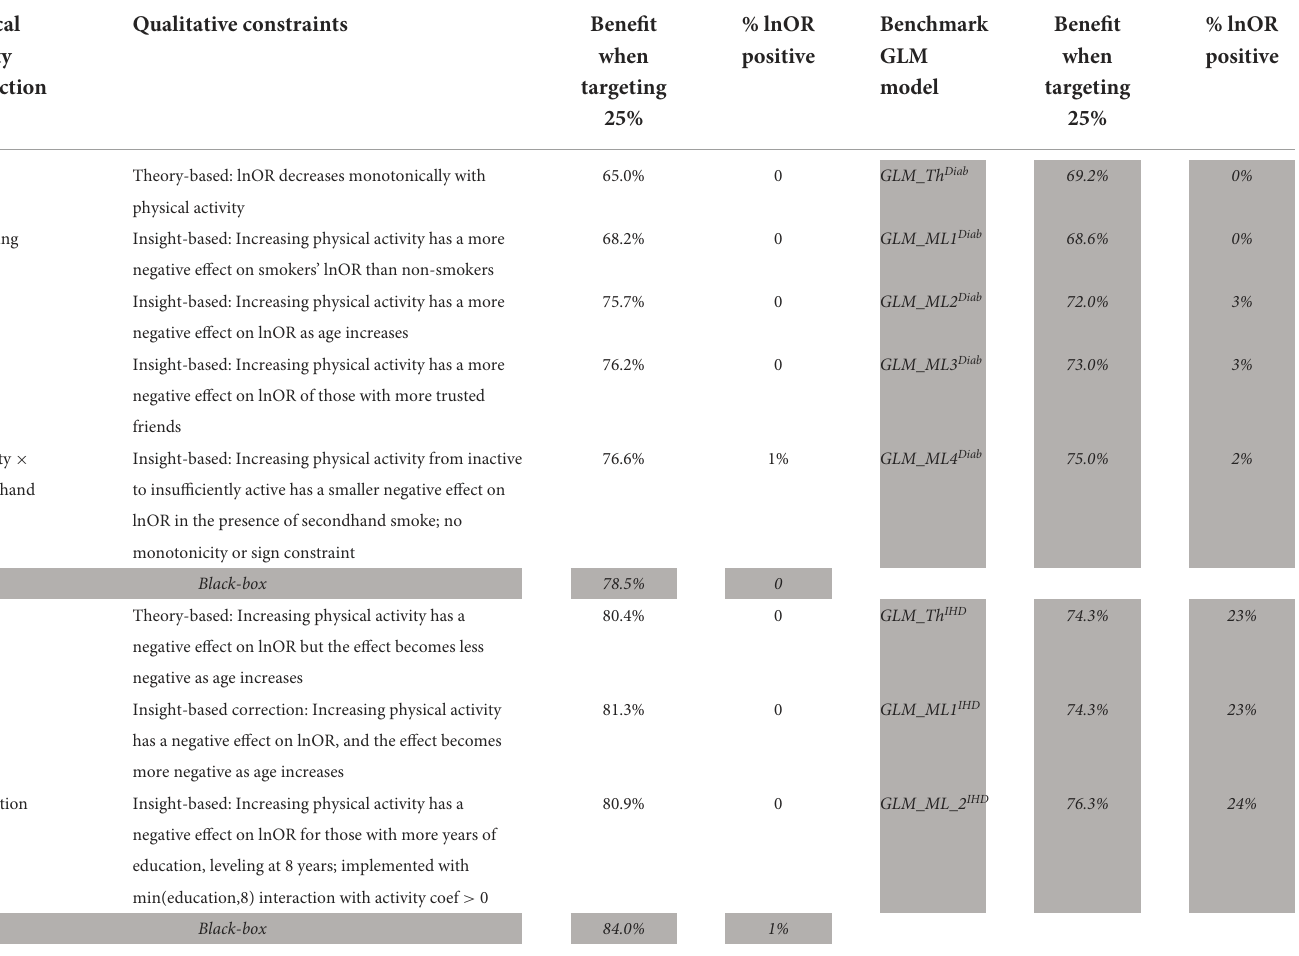
TABLE 3 Summary of the GLM_QC models and unconstrained